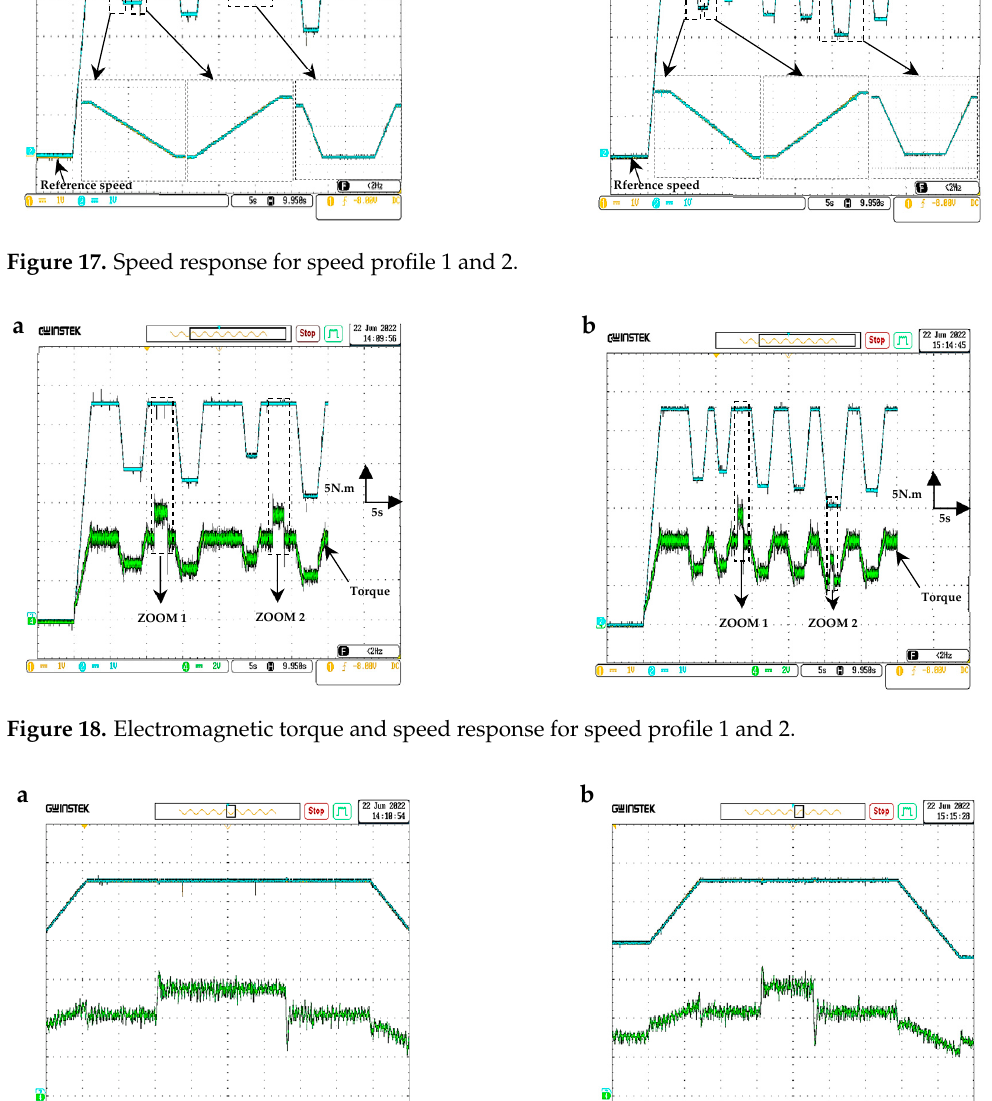
Figure 17. Speed response for speed profile 1 and 2.